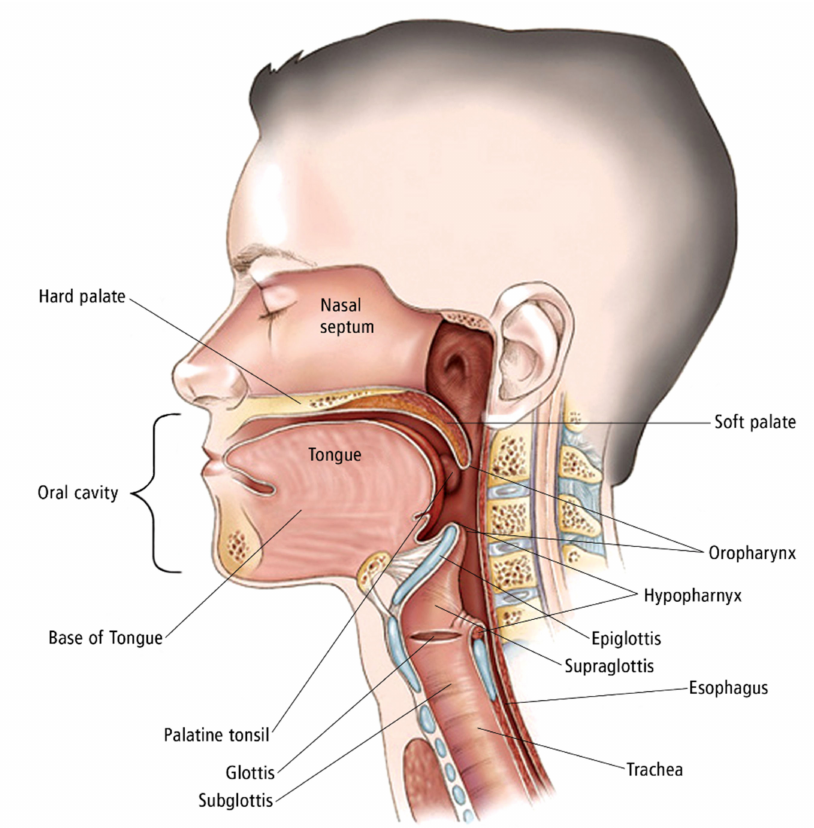
Figure 1. Illustration of the head and neck. The oral cavity includes the mucosal surface of the lips, the anterior two-thirds of the tongue, buccal mucosa, retromolar trigone and the hard palate. The oropharynx just posterior to the oral cavity includes the soft palate, the palatine tonsils, and base of the tongue. The nasopharynx located superiorly is bordered by the nasal cavity, clivus, soft palate, and sphenoid. The larynx includes the supraglottis, glottis, and subglottis. The hypopharynx just posterior to the larynx includes the following subsites: piriform sinus, postcricoid space, and posterior pharyngeal wall. Additional sites of the head and neck including the nasal cavity and paranasal sinuses (not imaged). Copyright 2005-2011 American Society of Clinical Oncology. Robert Morreale/Visual Explanations,